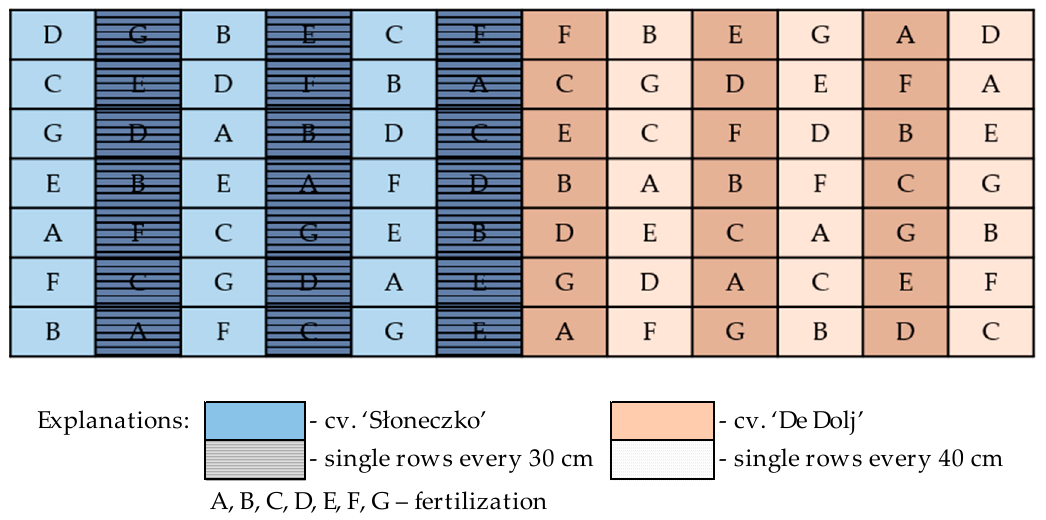
Figure 1. Design of the field experiment on the cultivation of thyme.